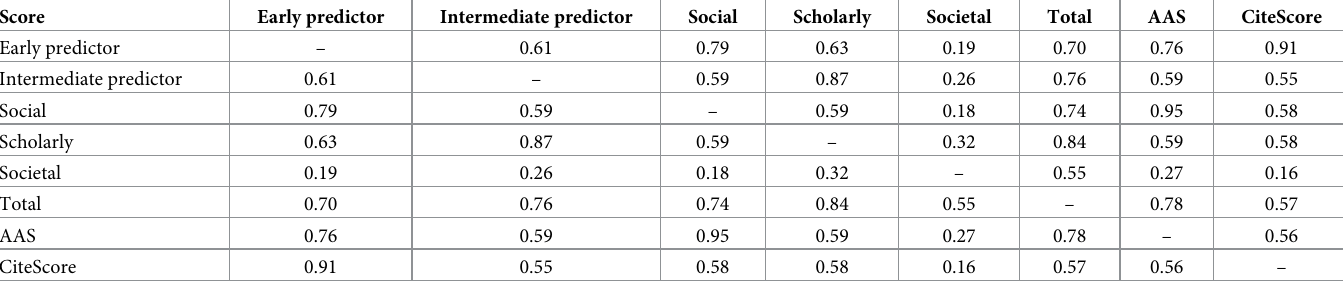
Table 5. Correlations (Spearman r) between component scores, AAS, and CiteScore in the reference Phase III sample. Correlations > 0.6 are shown in